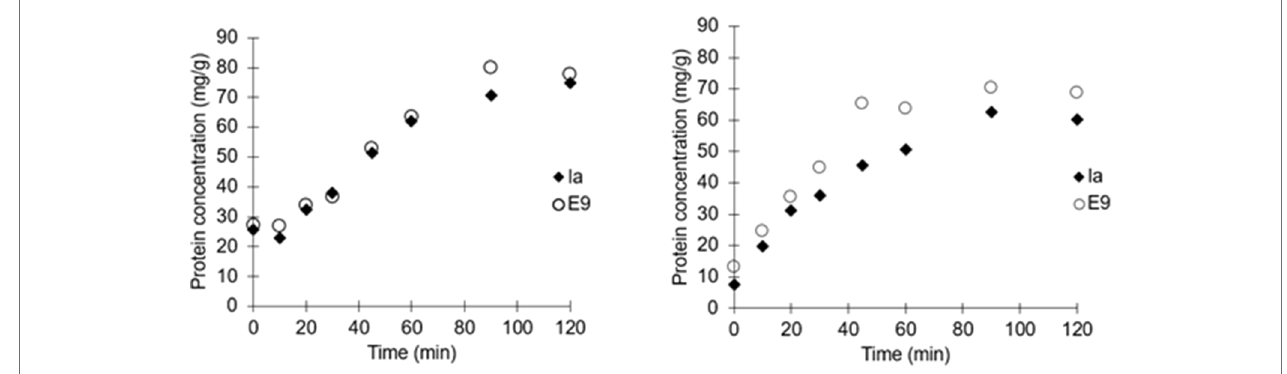
FIGURE 3 | Release kinetics of individually encapsulated colicins Ia and E9. Microcapsules exposed to simulated intestinal fluid buffer (SIF) at pH 5.5 (Left). Release kinetics of individually encapsulated colicins Ia and E9 in microcapsules exposed to simulated gastric fluid (SCF; pH 2.5) for 2 h followed by release in SIF at pH 5.5